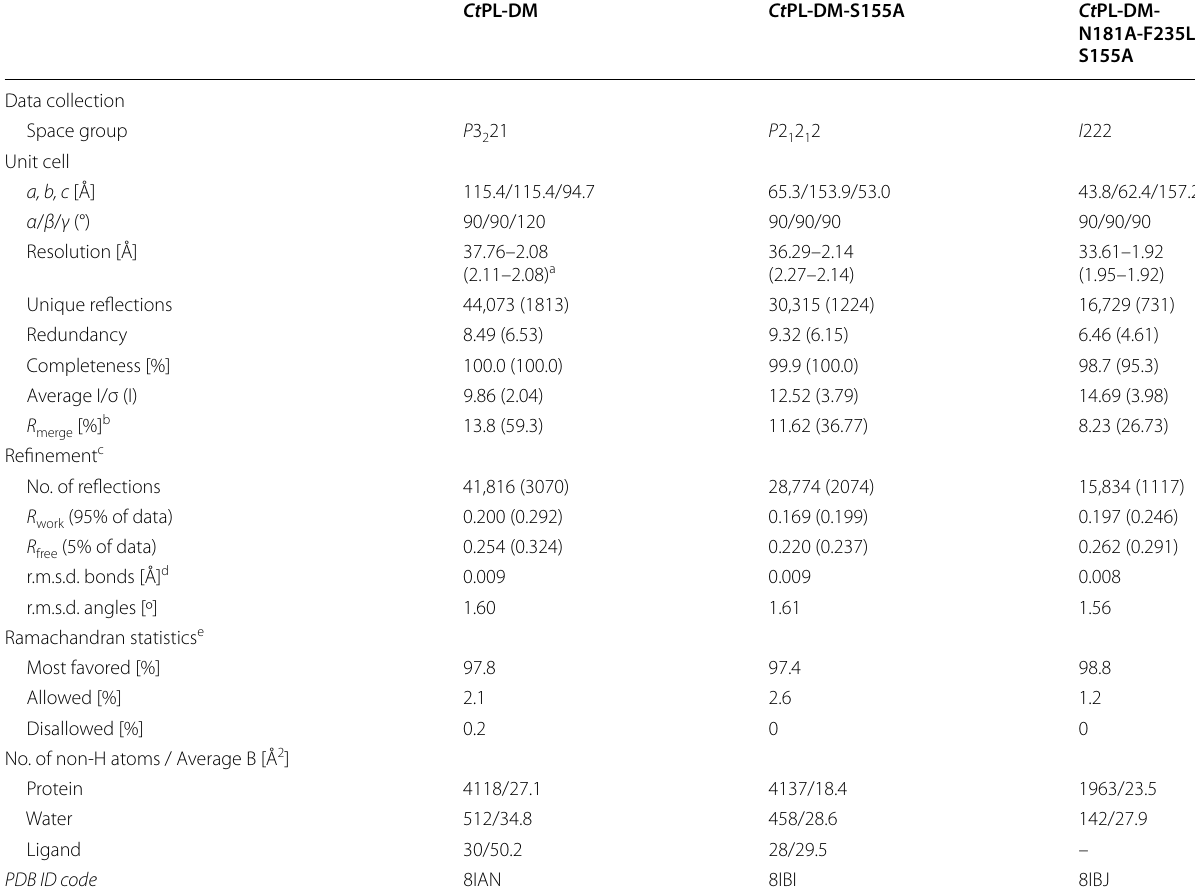
Table 1 Data collection and refinement statistics of Ct PL‑DM crystals